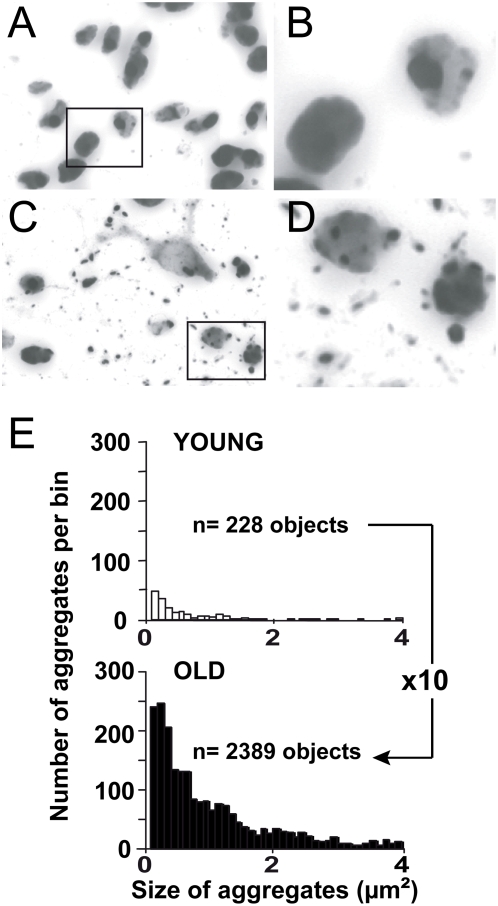
High resolution image analysis of EM48-positive aggregates indicates major age-dependent differences.Young (3 week) and old (15 month) rats received a stereotaxic injection of lentiviral vectors encoding Htt171-82Q (2 µl, 200 ng/µl of p24). Histological evaluation was carried out 4 weeks after infection using EM48 immunohistochemistry and image analysis software. The number of EM48 positive objects (aggregates) was determined from images obtained using a 50× objective at different focal depths (see Materials and Methods) so that very small EM48 positive objects could be detected. Typical images acquired at 50× objective in a young rat (A) and an old rat (C). B and D correspond to zoomed images of the rectangles in A and B. Note the high resolution of the images allows reliable detection of even small aggregates. E, Histograms showing the distribution of small objects as a function of size (apparent cross-sectional area) in two animals, indicating that the proportion of very small aggregates in old rats is approximately ten fold higher than in young animals.